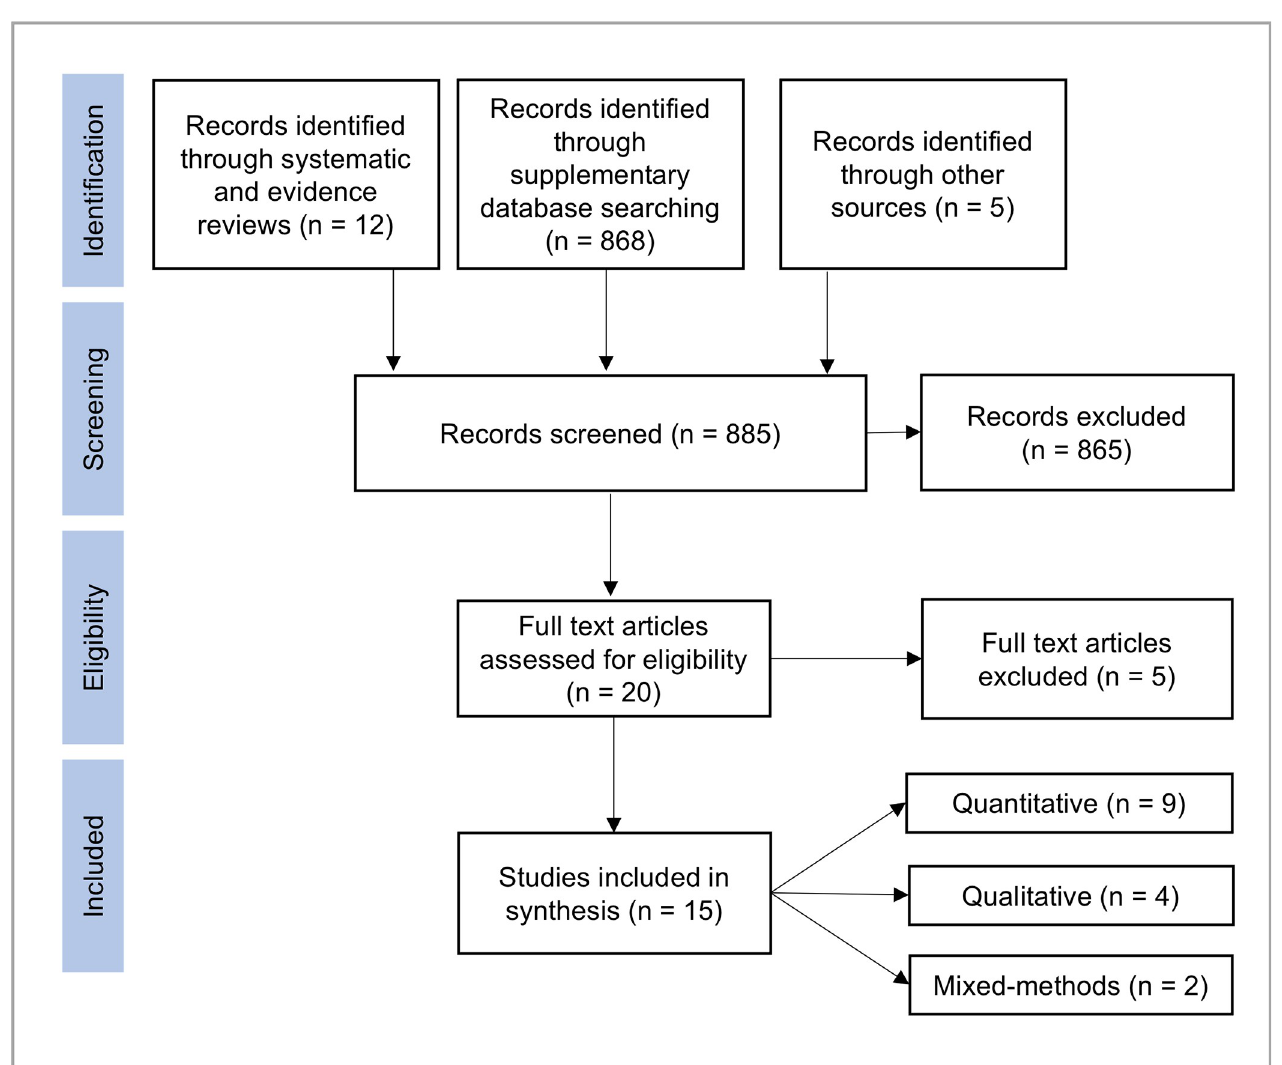
Fig 1. Flow diagram describing number of articles selected at each